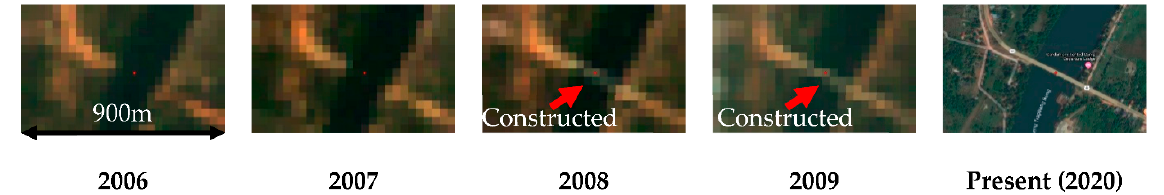
Figure 13. Satellite images of Tra Peang Roung bridge, from which it can be clearly observed that the bridge was constructed in 2008.